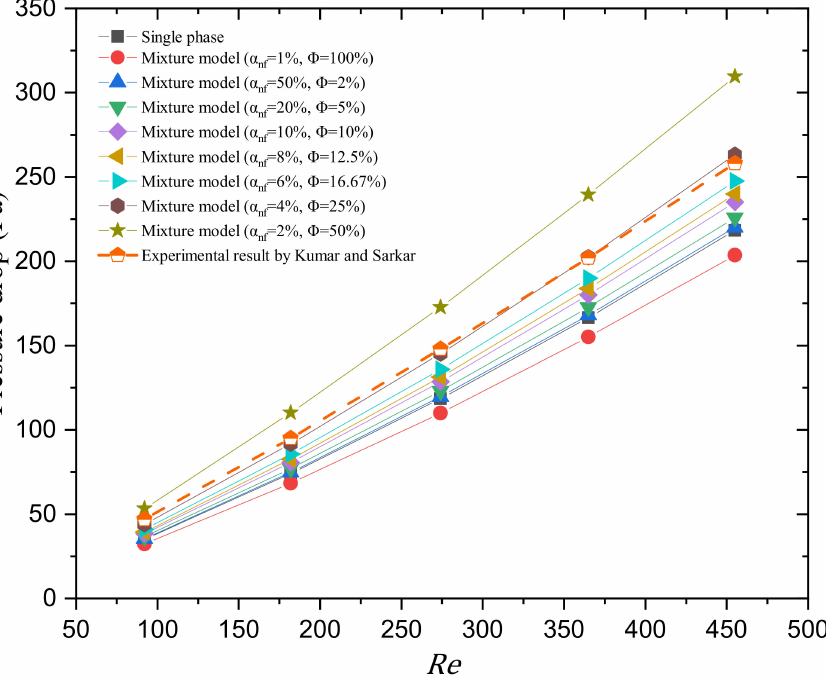
Figure 9. Minichannel inlet to outlet pressure drop ( ∆ p ) from the single-phase approach and the two-phase mixture model at 92 ≤ Re ≤